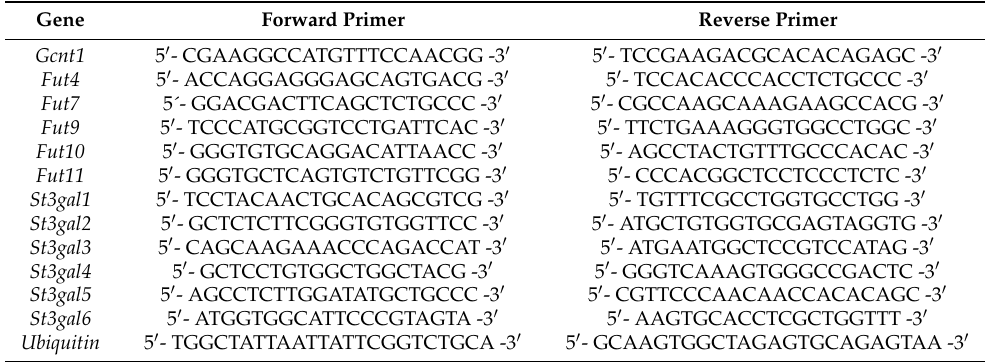
Table 2. Oligonucleotide sequences used for mice glycosyltransferases quantitative real-time PCR